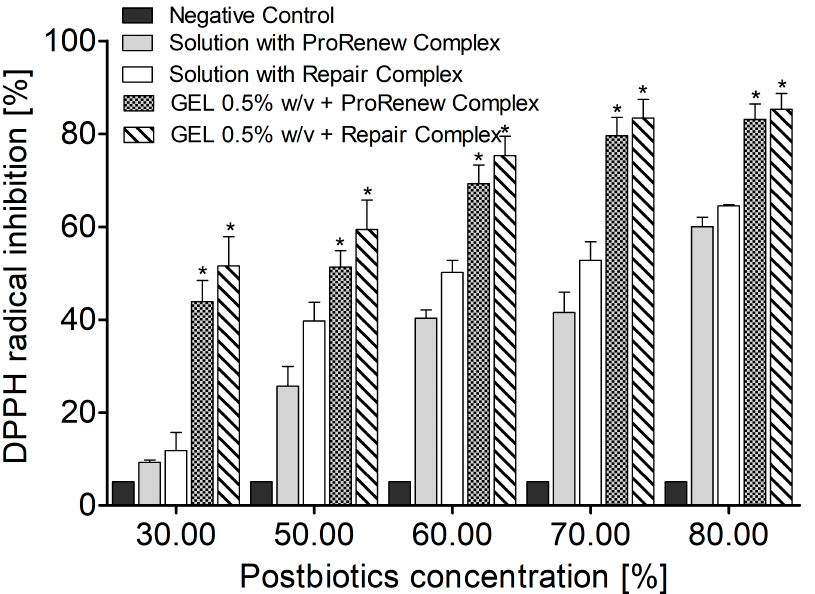
Figure 5. DPPH radical inhibition (%) by POSTBIOTICS in solution and in gel with 0.5% of Boc-L- DOPA(Bn) 2 -OH (mean value ± SD, n = 3). Negative control presents solution of L-DOPA in DMSO. The stars (*) above the columns indicate a statistically significant difference ( p < 0.05) between specific postbiotics in solution vs. in gel at a given concentration.